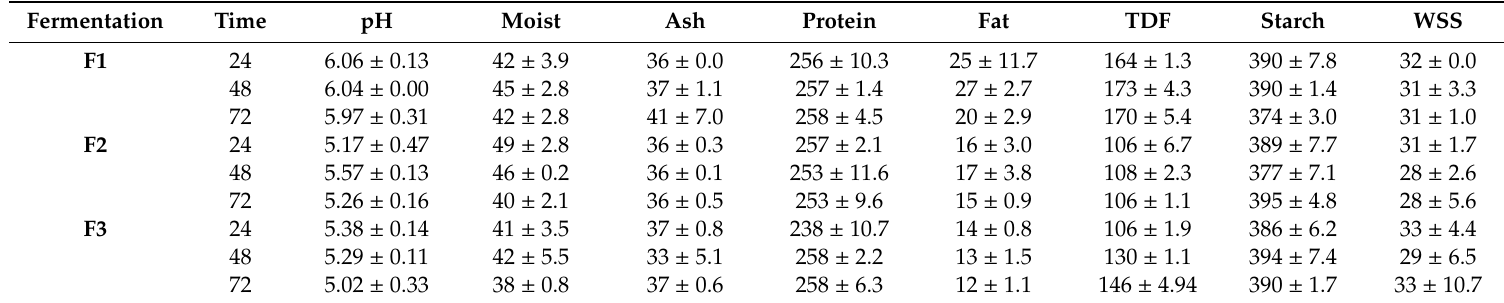
Table 2. Evolution of pH and chemical composition (g · kg − 1 DM) of cowpea beans-flour not inoculated (F1, control), subjected to controlled fermentation with a single culture of Lactobacillus plantarum (F2) or inoculated with a consortium of L. plantarum , Oenococcus oeni, Saccharomyces cerevisiae and Acetobacter aceti (F3) along di ff erent times of fermentation (24, 48, 72 h). All experiments presented as mean values and respective standard deviation ( n =